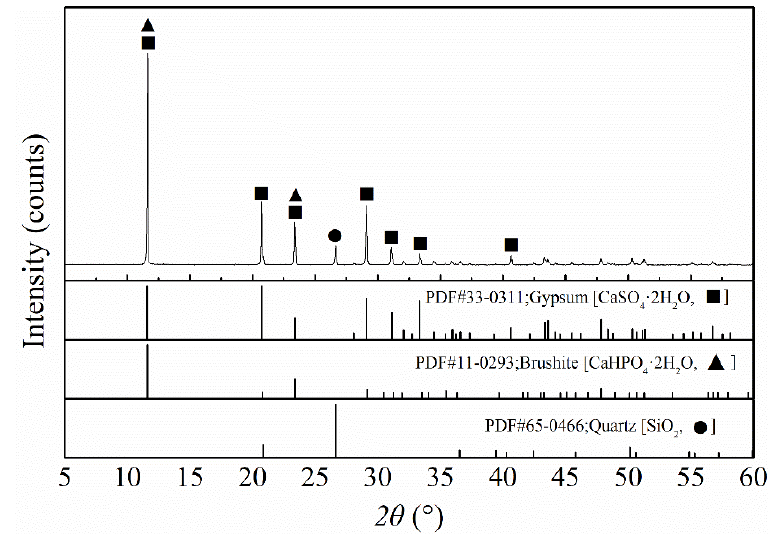
Figure 4. XRD pattern of the PG.